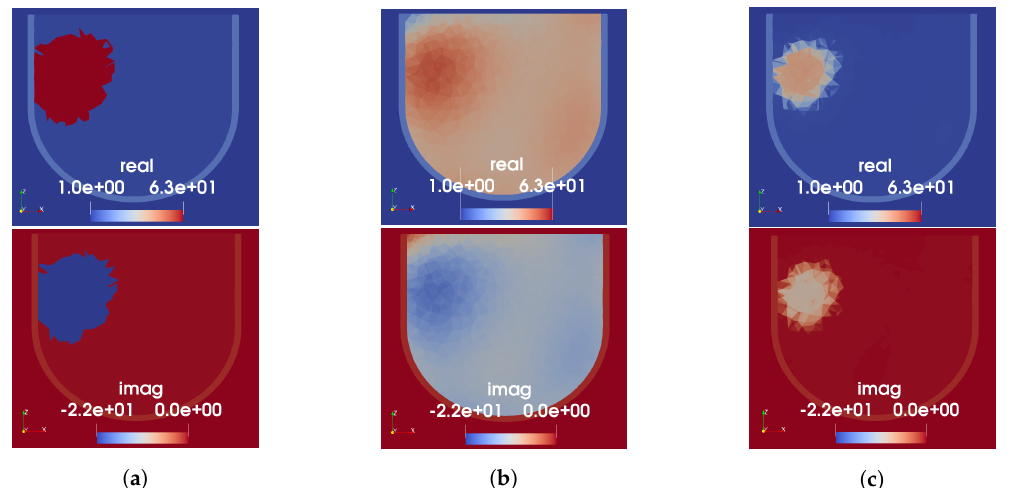
Figure 6. US-derived permittivity maps for Phantom 1. Each column shows real (top) and imaginary (bottom) parts of relative permittivity. ( a ) Segmented mapping. ( b ) Linear mapping. ( c ) Tissue- range